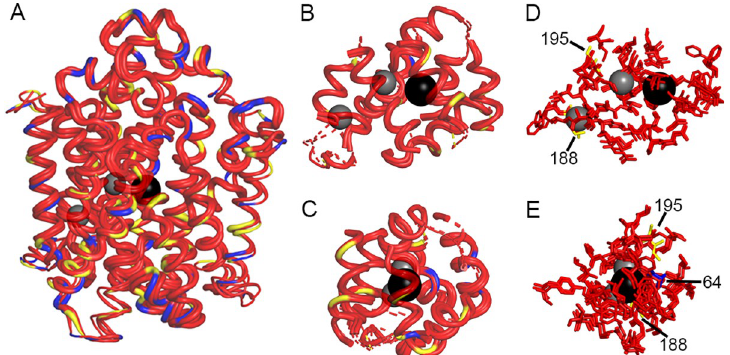
Fig 8. Molecular models of human-, minke whale-, and zebrafish NIS. (A) Overlap of hNIS, wNIS, and zNIS. The thickness of the alpha-helices and loops represent per-residue RMSD values calculated between the corresponding residues of hNIS, wNIS, and zNIS with hNIS as a reference. Thick alpha helices and loops signify low RMSD values (regions with high structural similarity). Color coding: red–fully conserved residues between hNIS, wNIS, and zNIS; yellow–substitution with a chemically similar residue in wNIS and zNIS; blue–substitution with non-similar residue; grey spheres–Na + ions, black sphere–I - ion. (B-C) Two different projections of protein areas within 10 Å of Na + and within 15 Å of I - . Dashed lines indicate some or all of residues in the alpha helix are outside the 10/15 Å cutoff. (D-E) Two different projections of residues from the ion coordination spheres (within 5 Å ) identified from MD simulations. The residue numbers of the non-conserved residues are also